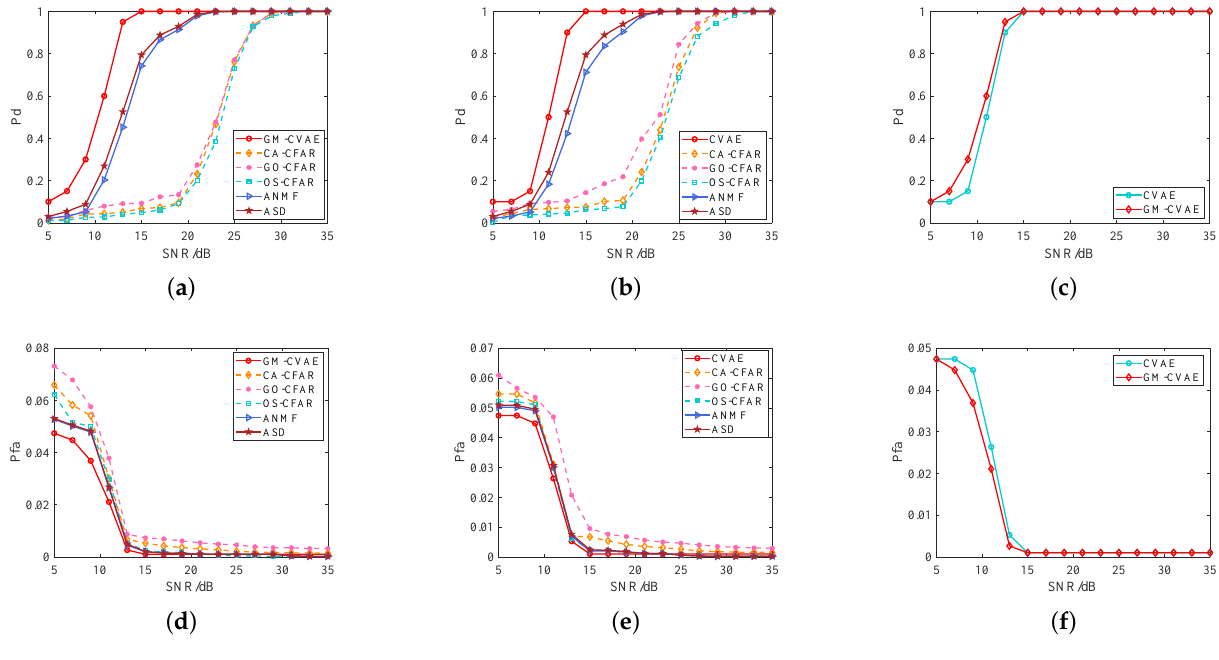
Figure 8. Single-scene performance for Type-2 clutter: Comparison of detection probability ( a ) be- tween GM-CVAE and CA-CFAR, GO-CFAR, OS-CFAR, ANMF and ASD methods; ( b ) between CVAE and the five traditional methods; ( c ) between GM-CVAE and CVAE; Comparison of actual false alarm rate ( d ) between GM-CVAE and the five traditional methods; ( e ) between CVAE and the five traditional methods; and ( f ) between GM-CVAE and